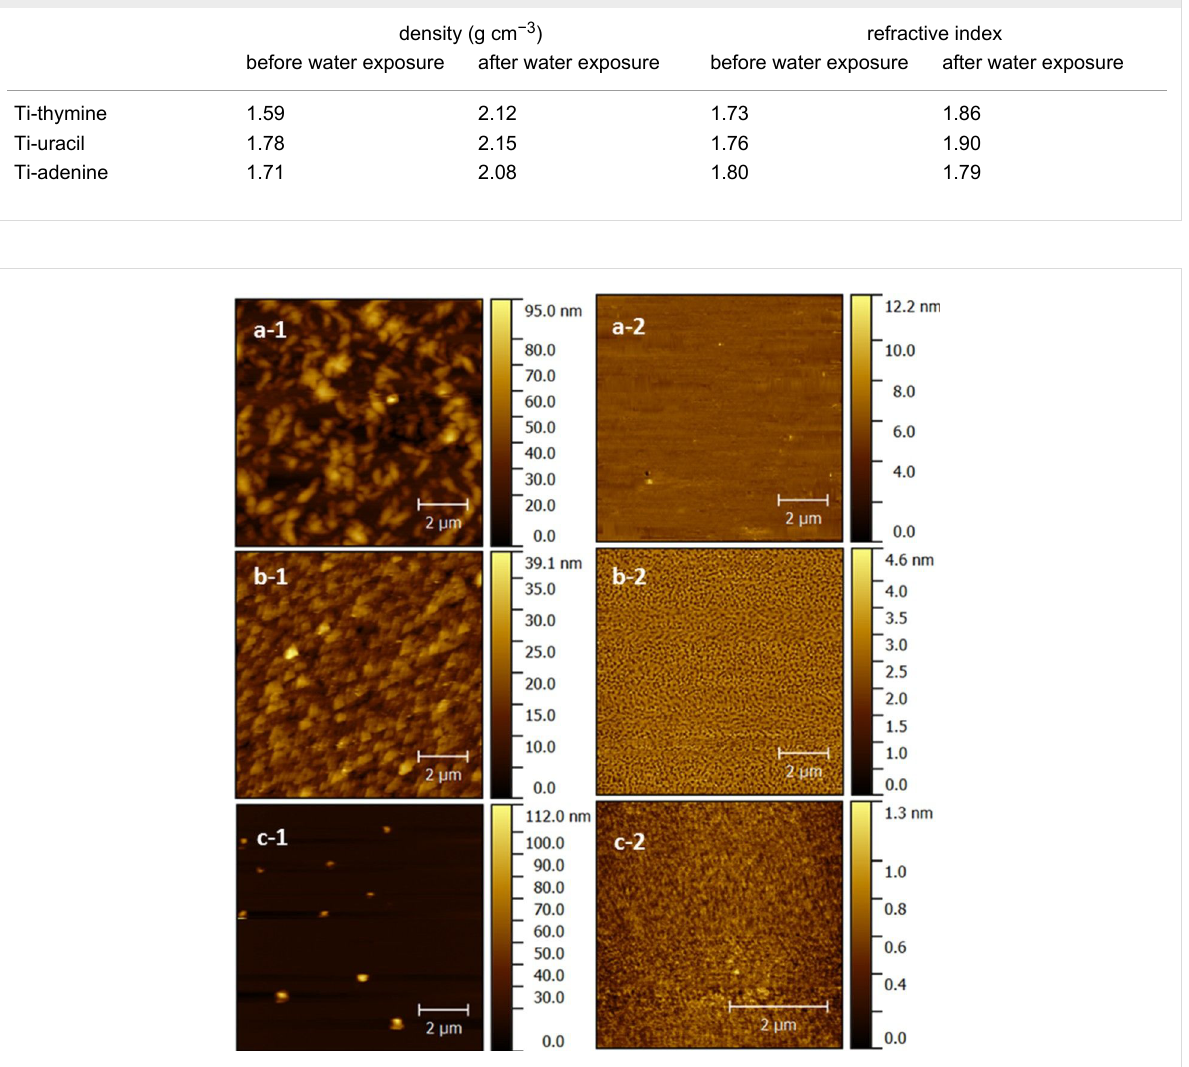
Table 3: Refractive index at 632.8 nm as measured by spectroscopic ellipsometry and film density as measured by XRR before and after exposure to water for Ti-thymine (at 250 °C), Ti-uracil (at 225 °C), Ti-adenine (at 250 °C).